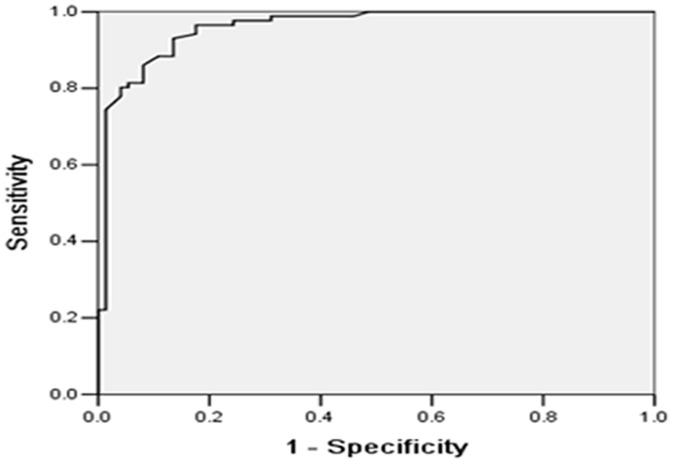
ROC curve of the serum YKL-40 levels of 120 SCLC patients and 40 controls.Serum levels of YKL-40 among 120 SCLC patients and 40 healthy controls were determined. The diagnostic potentials of YKL-40 were assessed by ROC curves. The AUC value was 0.96.